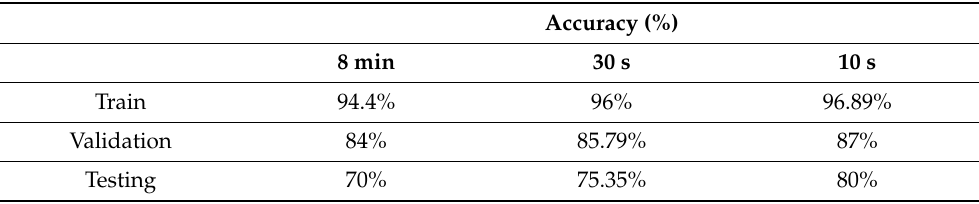
Table 9. Accuracy results for model 2 (training vs. validation vs.